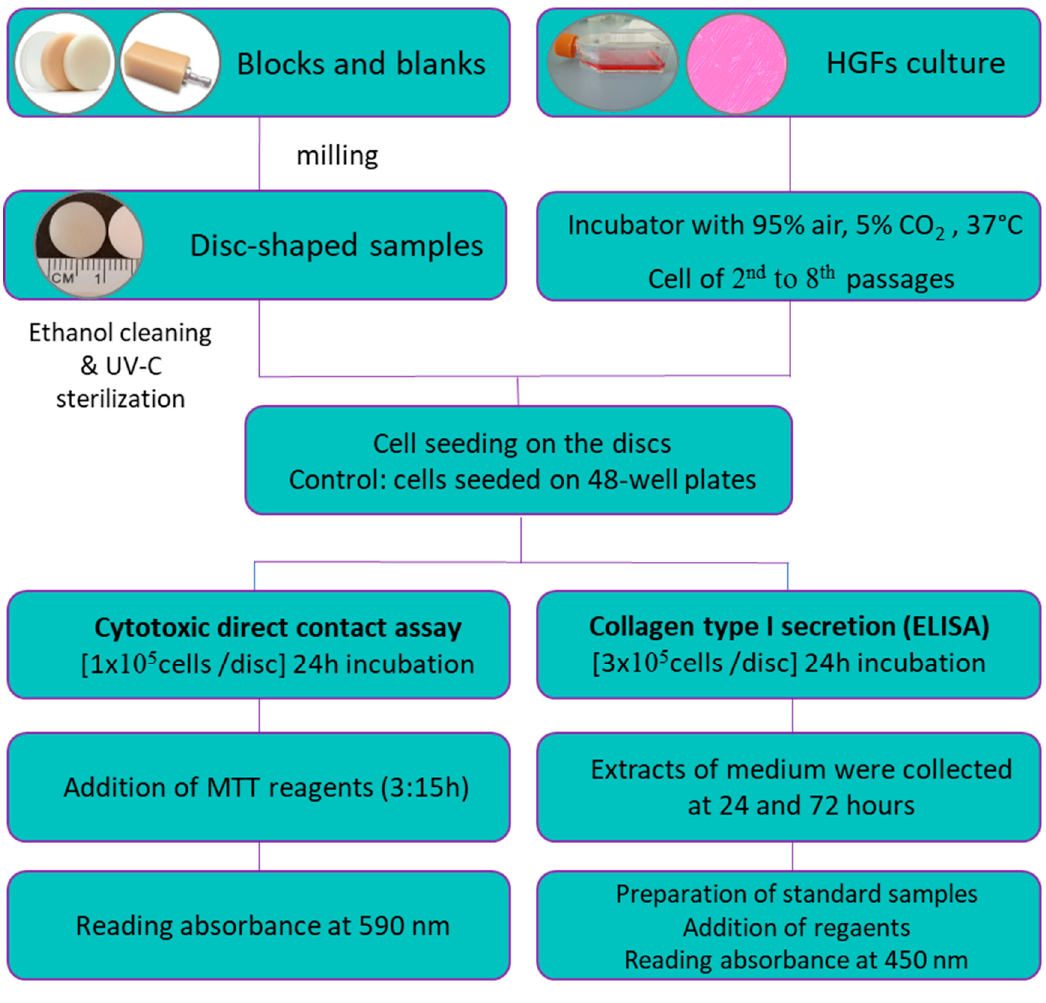
Figure 2. Diagram of the study design.